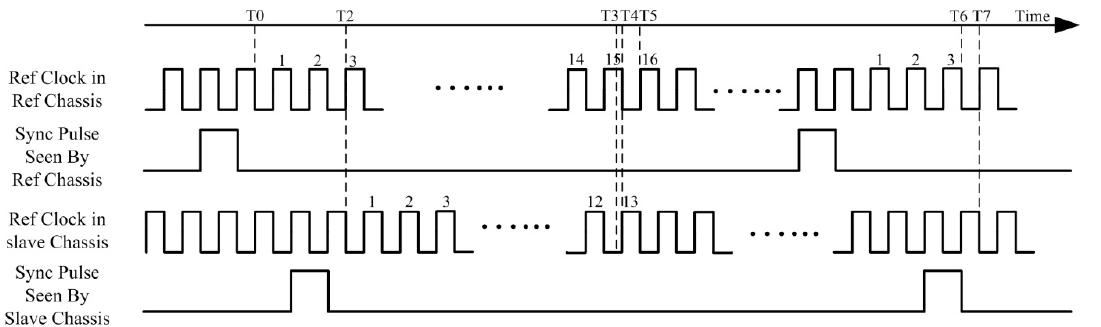
Figure 9. Example timing sequence of multi-chassis synchronization.